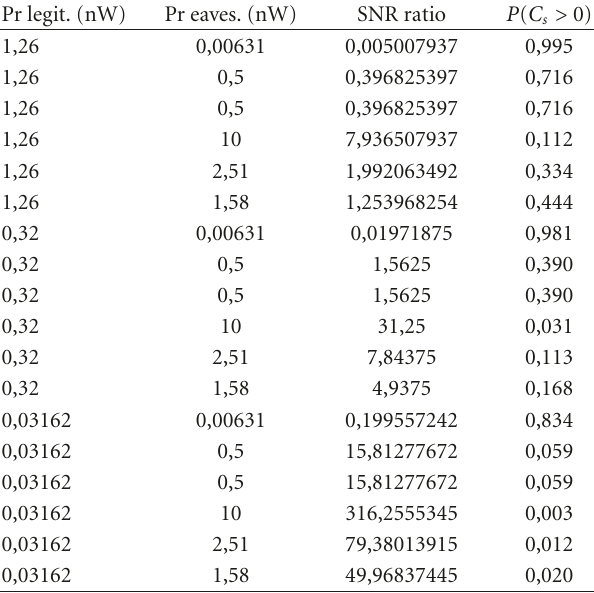
Figure 3: Measurement topology for OLOS schemes.